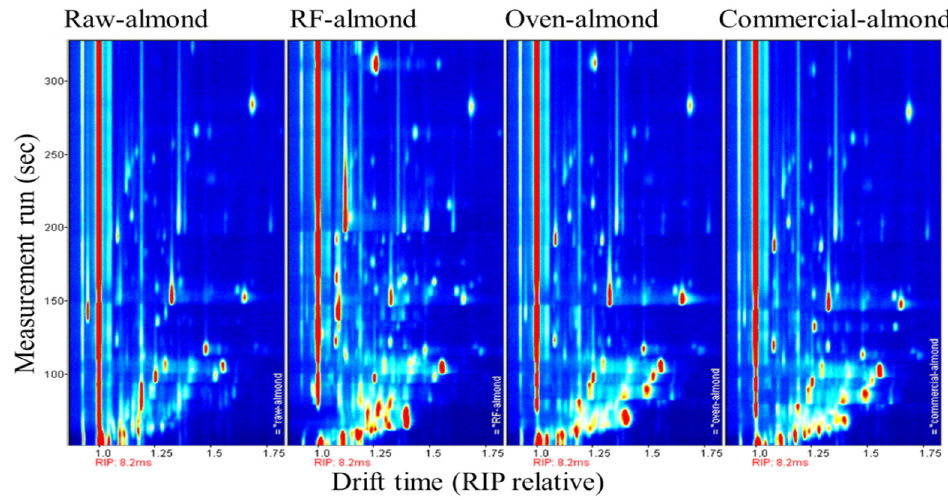
Figure 7. GC–IMS plot comparison of raw, RF-roasted, oven-roasted, and commercial almonds.